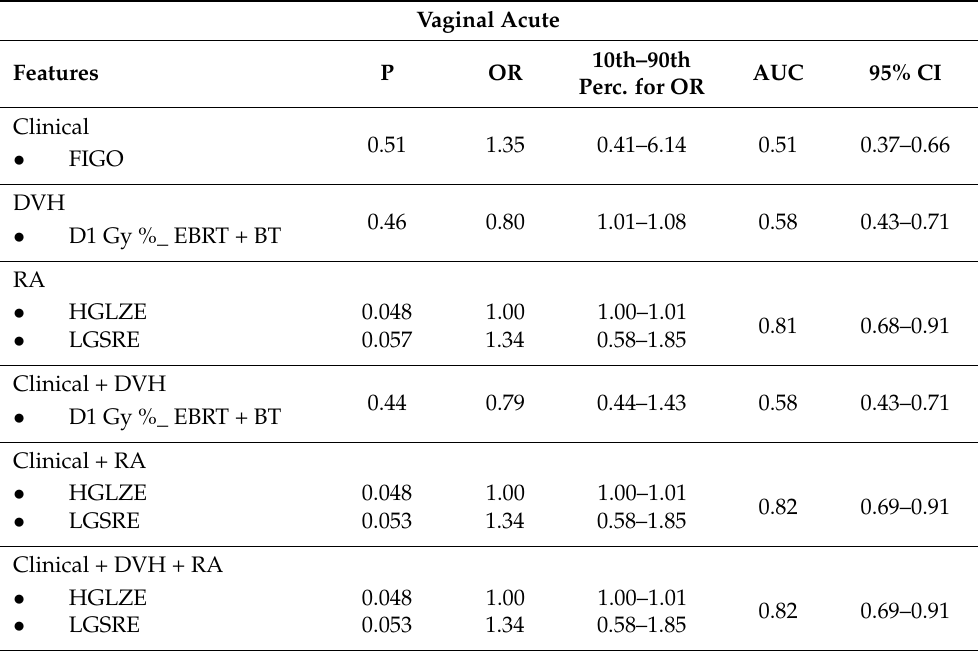
Table 3. Results of the multivariate logistic analysis for acute vaginal toxicity.